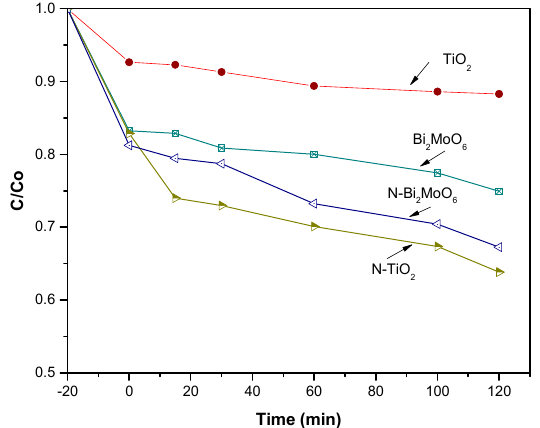
Figure 9. Lignin degradation in presence of TiO 2 , N-TiO 2 , Bi 2 MoO 6 , and N-Bi 2 MoO 6 catalysts under VIS energy irradiation.